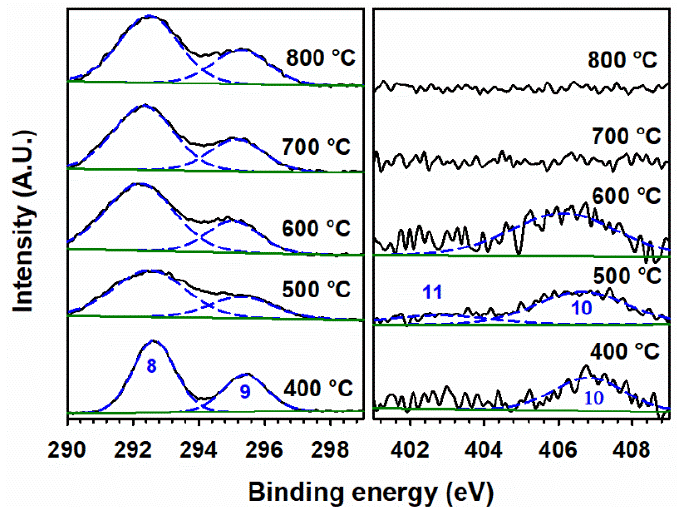
Figure 8. (Black trace) High-resolution XPS spectra of ( left panel ) K 2 p and ( right panel ) N 1 s for 100 Fe:5 K material, calcined at the indicated temperatures. (Dashed blue) Fitted peaks numbered (8) K 2 p 3/2 , (9) K 2 p 1/2 , (10) nitrate, and (11) nitrite. (Solid green) Fitted background.